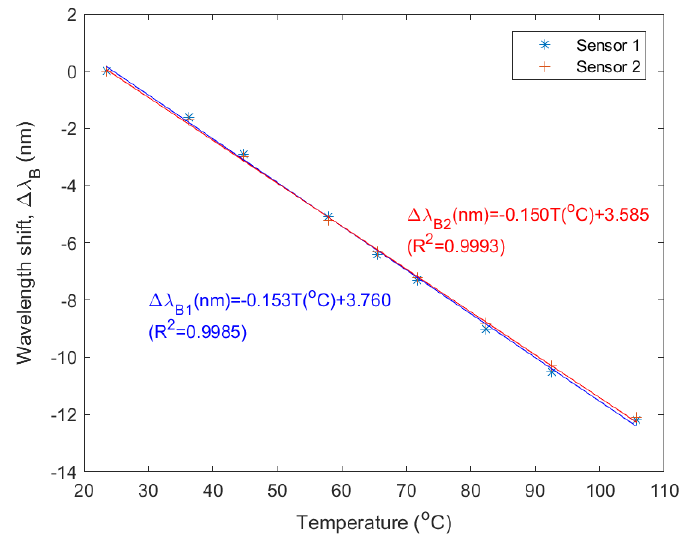
Figure 11. Bragg wavelength shift as a function of temperature for sensor 1 and sensor 2.